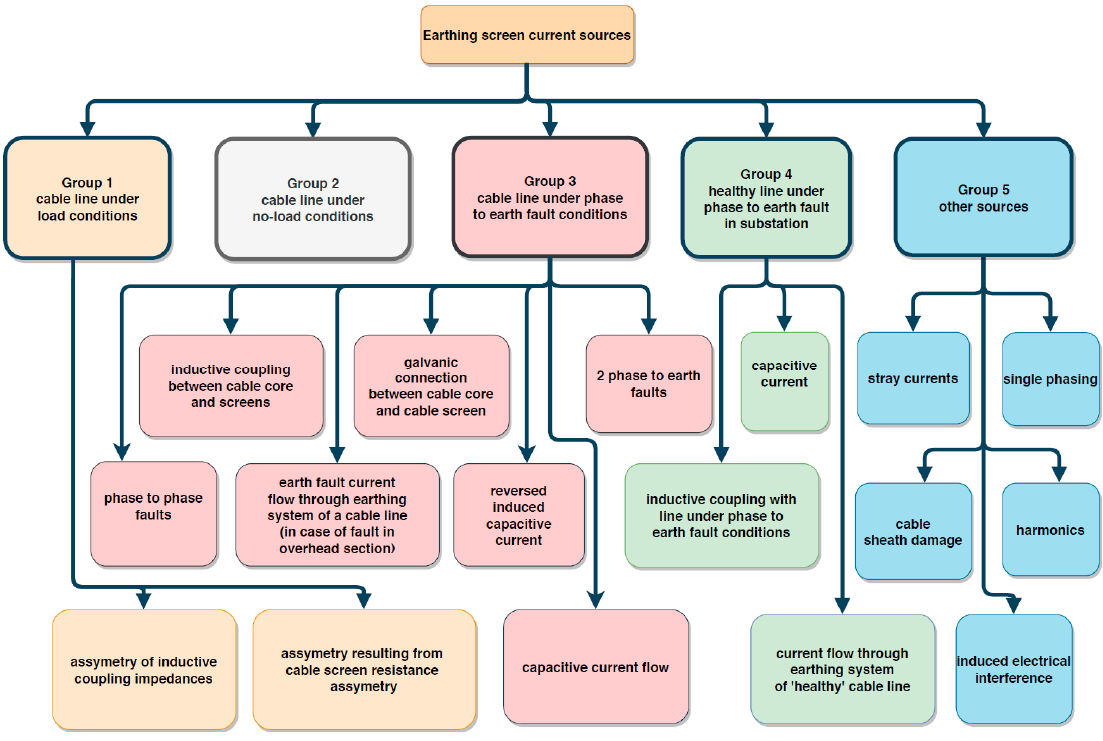
Figure 1. Earthing screen current sources.